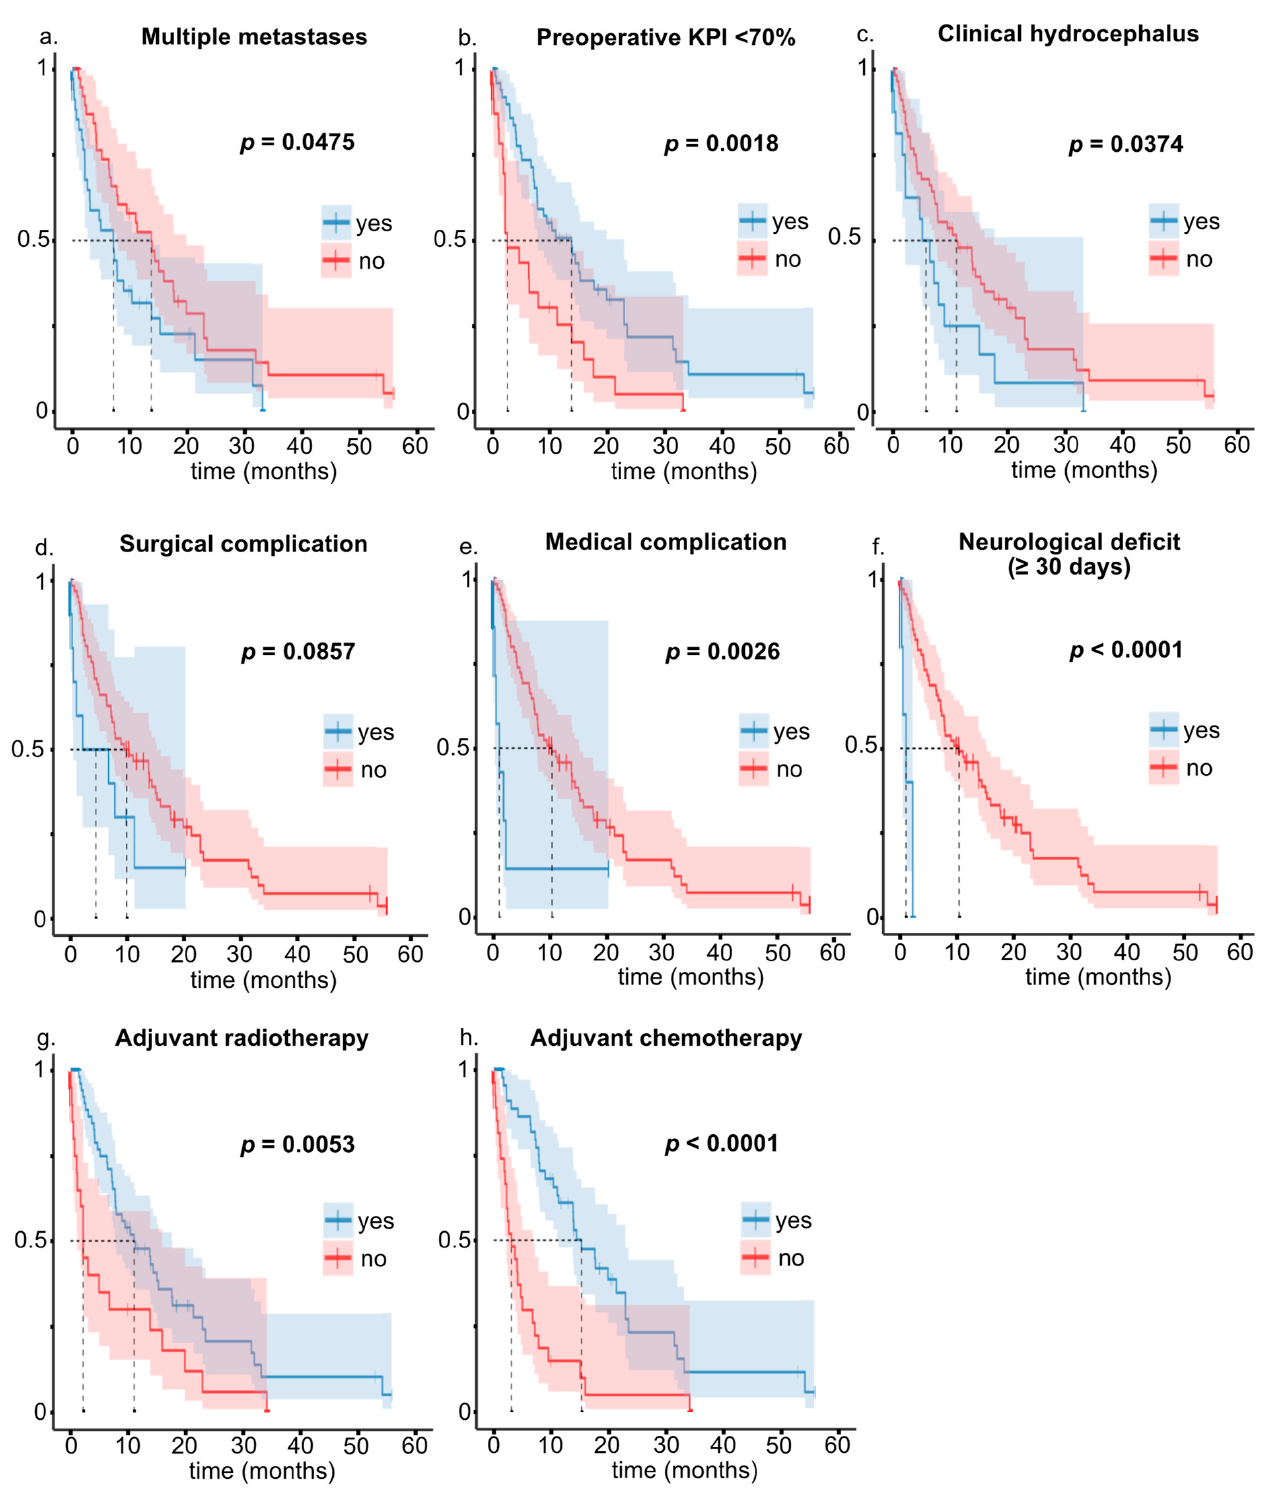
Figure 1. Kaplan–Meier estimates of overall survival stratified by prognostic parameters: ( a ) multiple metastases, ( b ) KPI < 70%, ( c ) clinical hydrocephalus, ( d – f ) major (CTCAE grades III–V) complications, ( g ) adjuvant radiotherapy, ( h ) adjuvant chemotherapy.